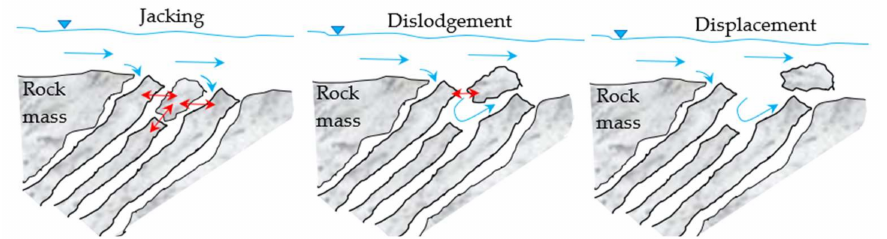
Figure 12. The block removal erosion mechanism for flow parallel to the bottom of the flow channel (modified from Annandale